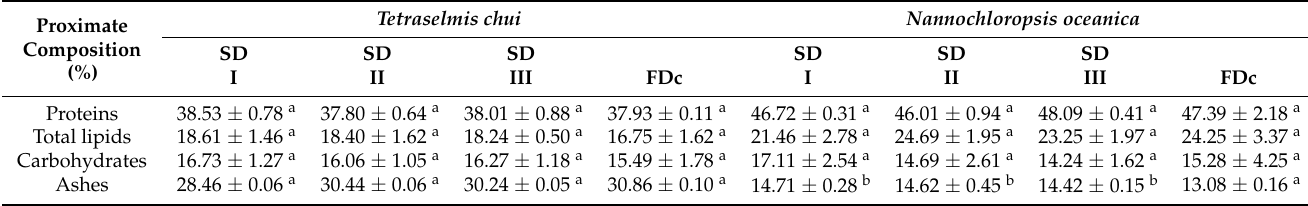
Table 2. Proximate composition (proteins, total lipids, carbohydrates, and ashes) of solar- (SD I, II, and III) and freeze-dried (control, FDc) Tetraselmis chui and Nannochloropsis oceanica biomass. Different letters represent significant differences among samples from the same species detected by Tukey’s post hoc range test (HSD, ANOVA). Data points for all samples are shown as mean ± standard deviation (Std Dev) ( n = 3).